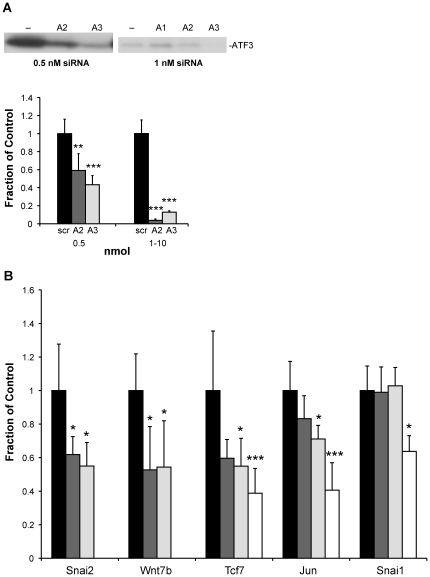
Decreases in gene expression following ATF3 knock-down in EMT6 cells.EMT6 cells were transfected with silencing RNAs A1, A2, or A3 as described in Materials and Methods, or with a scrambled version of A1, at the indicated concentrations. A, 48 h later extracts were analyzed for ATF3 protein expression by immunoblotting (upper panels) or for mRNA expression by qPCR (lower panel). Gene expression levels are expressed relative to expression in cells treated with the scrambled siRNA. The statistical significance of differences between mean expression levels, calculated relative to the scrambled siRNA control, is indicated over the bars of the histograms: *, p<0.05: **, p<0.01: ***, p<0.001. B, qPCR was used to analyze the same extracts for Snai2, Wnt7b, Tcf7, Jun, and Snai1 as indicated. Black bars, scrambled siRNA; dark gray bars, 0.5 nmol A2siRNA; light gray bars, 0.5 nmol A3siRNA; white bars, 1–10 nmol A2siRNA.